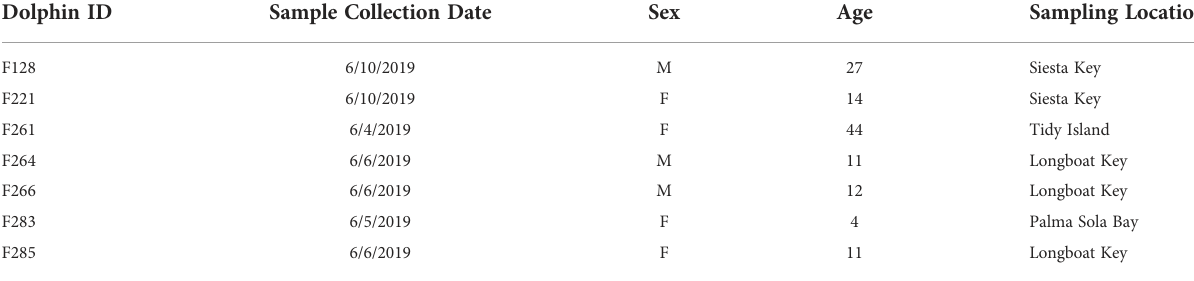
TABLE 2 Characteristics of bottlenose dolphins sampled in Sarasota Bay, Florida during health assessments (2019). Dolphin